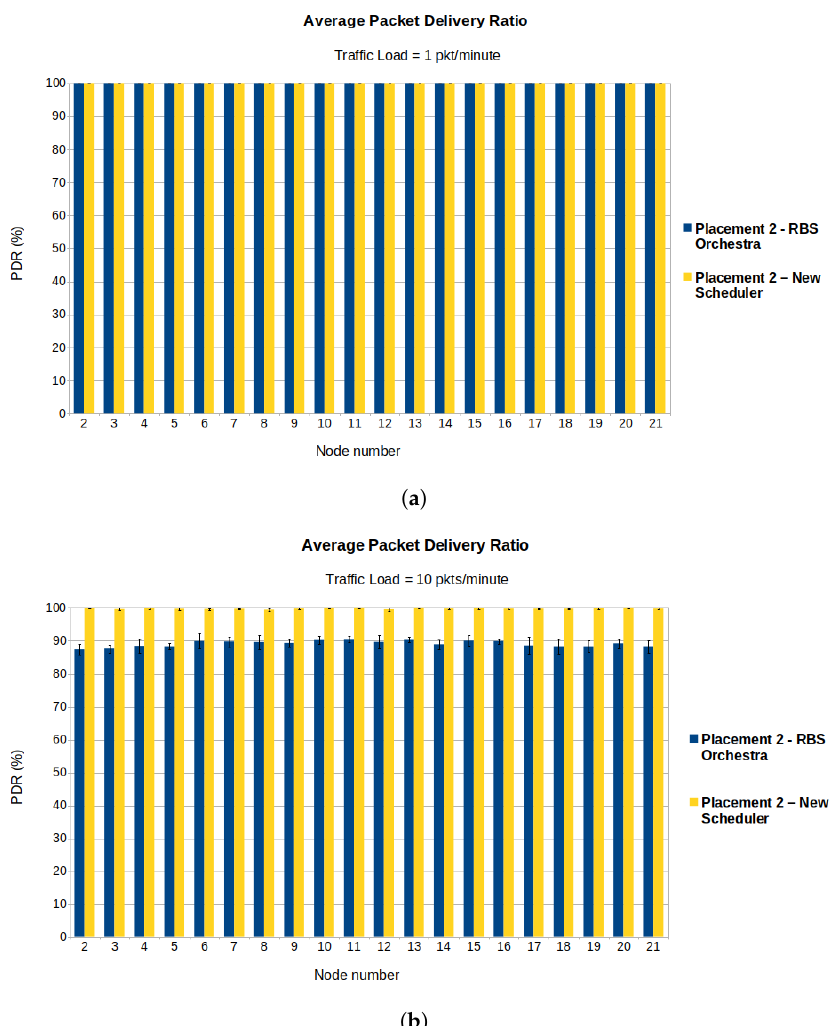
Figure 12. Average PDR for each sender node in low and high traffic situations. ( a ) We observe that in normal traffic situation, the average PDR is high for both schedulers. ( b ) We observe that in a high traffic situation for RBS Orchestra, the average PDR is lowest for the root’s children, being nodes